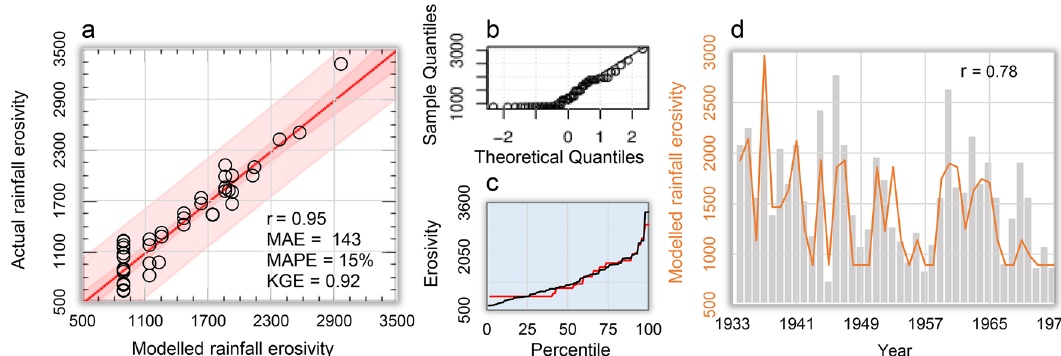
Figure 4. Rainfall erosivity model calibration and indirect validation for the Tiber River Basin. ( a ) Scatter-plot (dotted black regression line and red line of identity) of actual versus modelled—Eq. (5)—rainfall erosivity (MJ mm hm −2 h −1 yr −1 ) for the 1923–1964 period, with the inner bounds showing 90% confidence limits (power pink coloured area), and the outer bounds showing 95% prediction limits for new observations (light pink); the MAE in the box in a) is also in MJ mm hm −2 h −1 yr −1 ; ( b ) Q-Q plot (theoretical versus sample quantile values); ( c ) Percentiles of actual (blue curve) and modelled (orange curve) rainfall erosivity; ( d ) Co-evolution of modelled annual rainfall erosivity (orange curve) and suspended sediment yield (grey histogram) at the mouth of the river Tiber in the 1934–1973 period 130